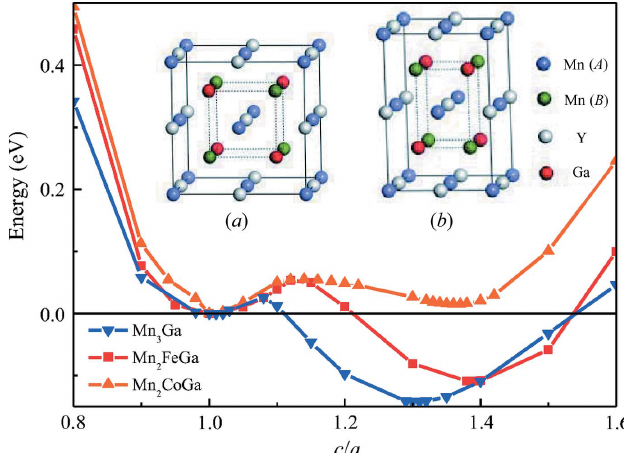
Figure 6 Total energy of the tetragonal structure as a function of the c / a ratio for Mn 2 Y Ga alloys ( Y = Mn, Fe, Co). Insets show schematic representations of the ( a ) cubic and ( b ) tetragonal Heusler compounds of Mn 2 Y